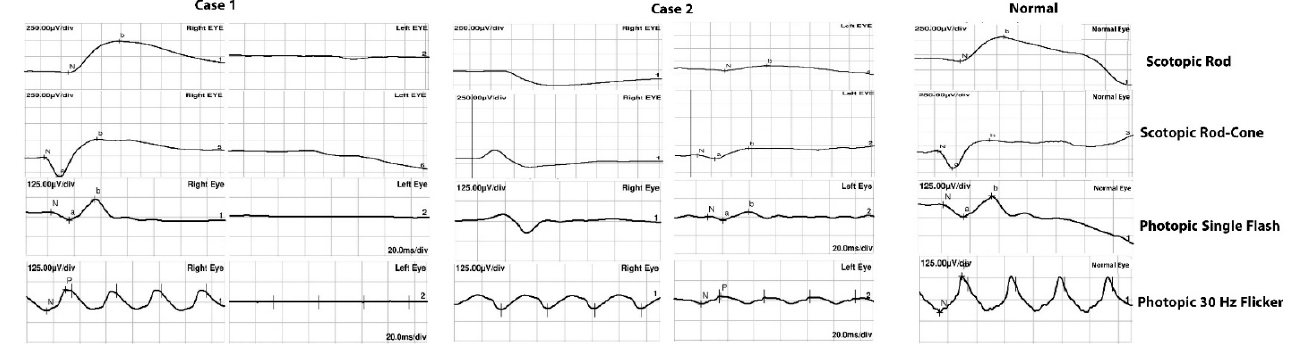
Figure 2. Full-field electroretinogram showing normal responses of the right eye and undetectable responses of the left eye in patient 1 a 32-year-old female with unilateral retinitis pigmentosa (URP) in the left eye with two heterozygous variants c.373 C>T (p.Arg125Trp) and c.730-22_730-19 dup in AGBL5 . Patient 2, a 65-year-old male with URP in the left eye, with RPGR missense variant c.1286 C>T (p.Pro429Leu), showed unrecordable responses of the right eye, while responses of the left eye were profoundly reduced.